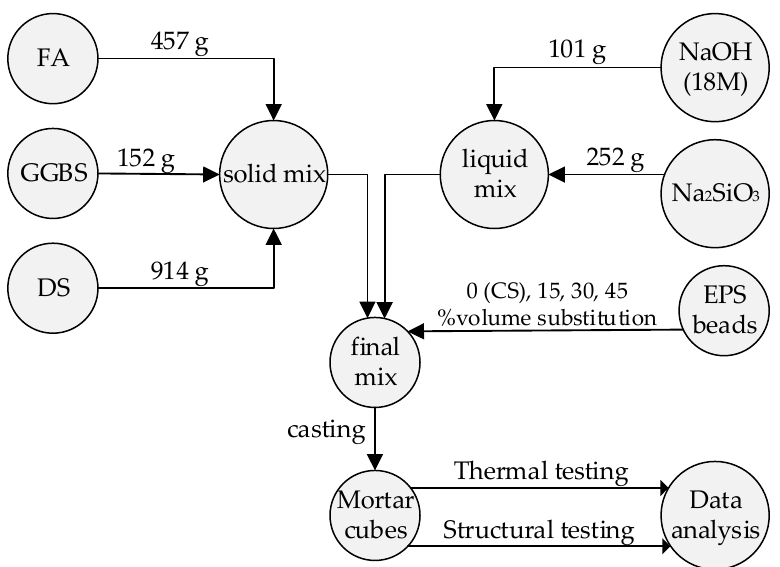
Figure 2. Flowchart diagram representing the sequence and mix proportions of the constituents of the GP and complete experimentation process; CS—control sample.